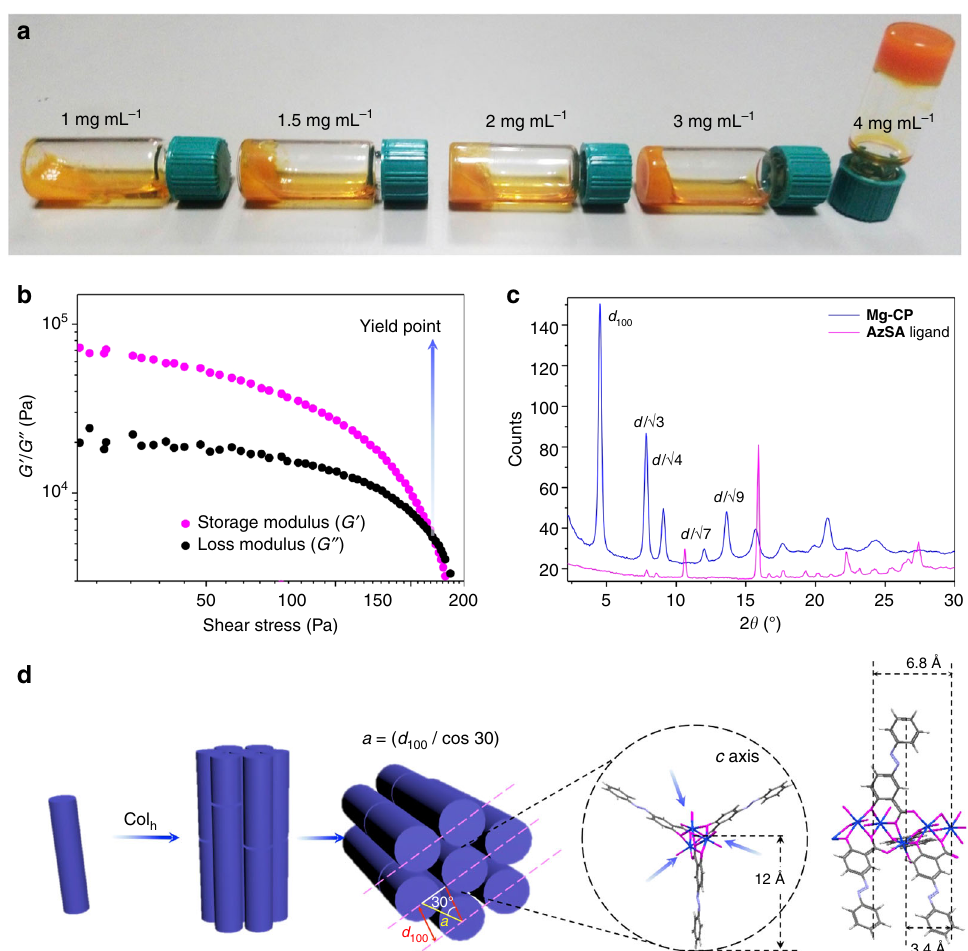
Fig. 3 Gelation behaviour of Mg-CP and structural analysis of the xerogel. a Photographs showing the gelation of Mg-CP at the critical gelation concentration (4 mg mL − 1 ). b Non-linear rheological response (amplitude sweep) of Mg-CP gel. c WAXS analysis of Mg-CP and AzSA . d Schematic representation of the molecular arrangement of columnar hexagonal (CoI h ) packing of Mg-CP polymeric strands and the calculated lattice parameter. Blue arrows represent coordinated solvent molecules